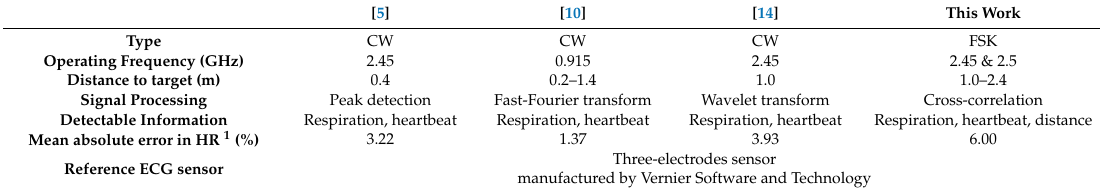
Table 3. Performance comparison of the proposed radar with the radars from our previous studies, which were used for vital-signs detection in a similar measurement